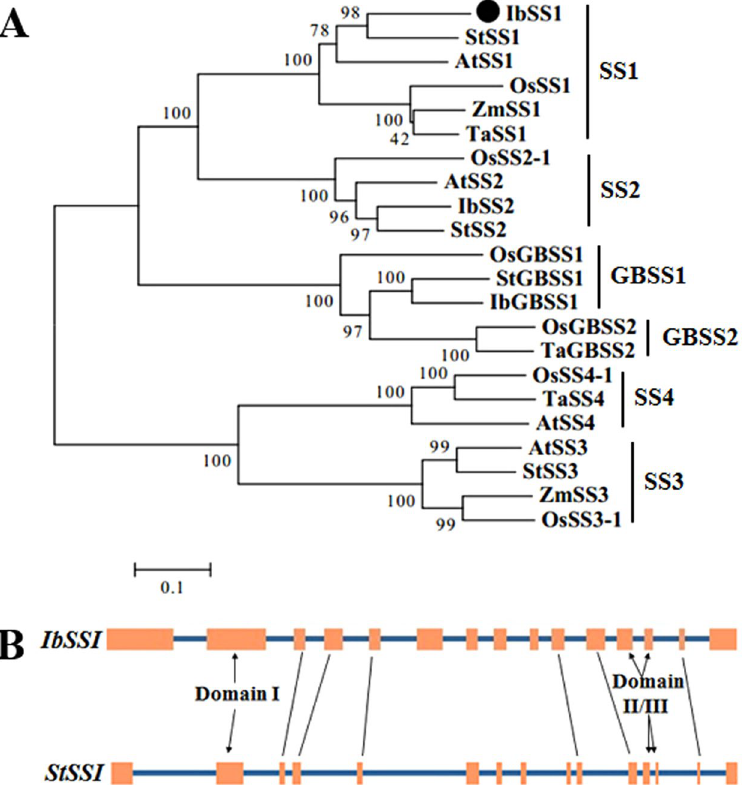
Figure 1. Sequence analysis of IbSSI . ( A ) Phylogenetic tree of the starch synthases of different plant species generated using MEGA 6.0 with the neighbor-joining method. The IbSSI cloned in this study is indicated by a black spot. The complete species names of the starch synthases and their GenBank accession numbers are listed in Supplementary Table S2. ( B ) Comparison of the genomic structures of IbSSI ( Ipomoea batatas ) and StSSI ( Solanum tuberosum ). The orange boxes represent the exons and the blue lines indicate the introns. Distributions of the three conserved domains are illustrated by black